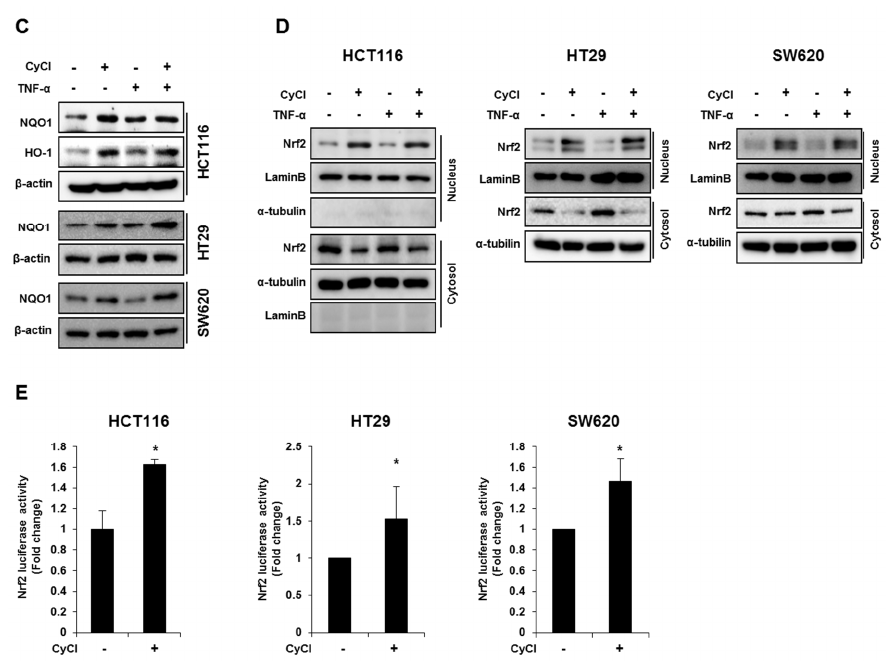
Figure 5. CyCl induces Nrf2 activation and the expression of antioxidant enzymes. ( A ) 2,2-Diphenyl-1-Picrylhydrazyl (DPPH) radical scavenging activity (%) of CyCl. ( B ) HCT116, HT29, and SW620 cells were treated with TNF- α and 50 µM of CyCl and incubated for 24 h. RNA was extracted from the cells and mRNA expression of NAD(P)H quinone dehydrogenase 1 (NQO1) and heme oxygenase-1 (HO-1) was measured by qRT-PCR analysis. ( C ) HCT116, HT29, and SW620 cells were treated with TNF- α and 50 µM of CyCl and incubated for 24 h. Protein extracts were separated by SDS-PAGE and Western blot analysis was conducted for the expression of NQO1 and HO-1 protein. ( D ) Representative immunoblots of nuclear and cytosolic proteins demonstrating changes in the subcellular localization of Nrf2 following CyCl treatment in TNF- α -stimulated cells. The quantitative results are expressed as the mean ± SD of three independent experiments. ( E ) HCT116, HT29, and SW620 cells were transiently transfected with Nrf2-Luc plasmids for 24 h and treated with 50 µM of CyCl for 24 h. Cell extracts were harvested, and luciferase assays were performed. All experiments were carried out in triplicate. * p < 0.05, ** p < 0.01, and *** p < 0.001, significantly different compared with control; # p < 0.05 and ## p < 0.01, significantly different compared with TNF- α -treated cells.